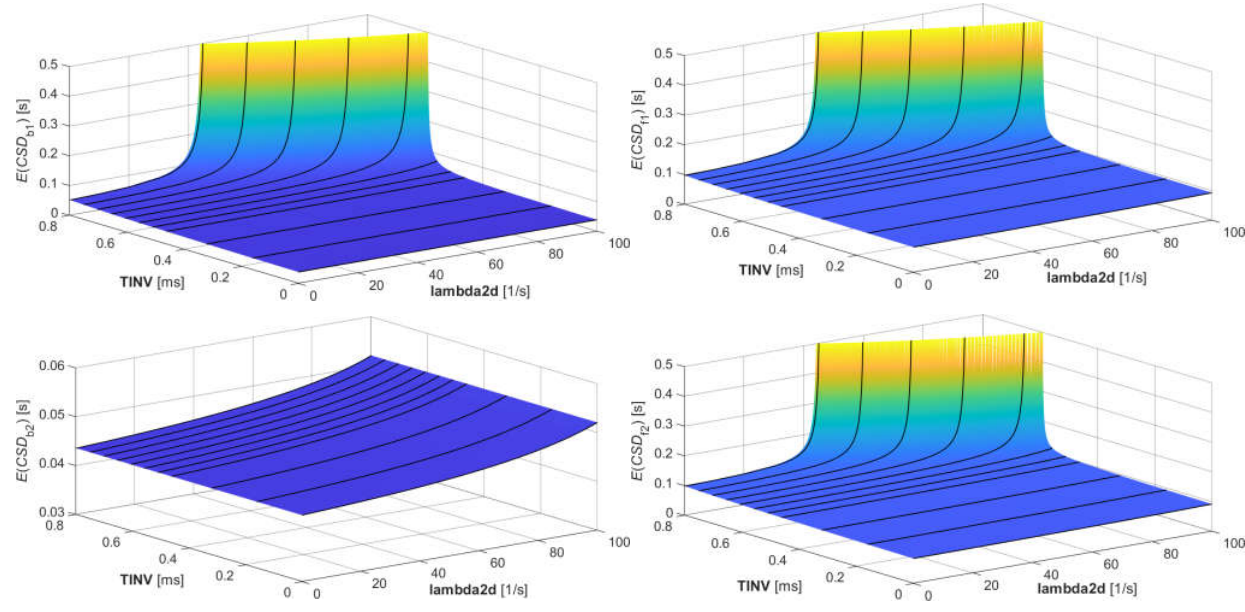
Figure 5. Selected results for data set 2 from Table 1.